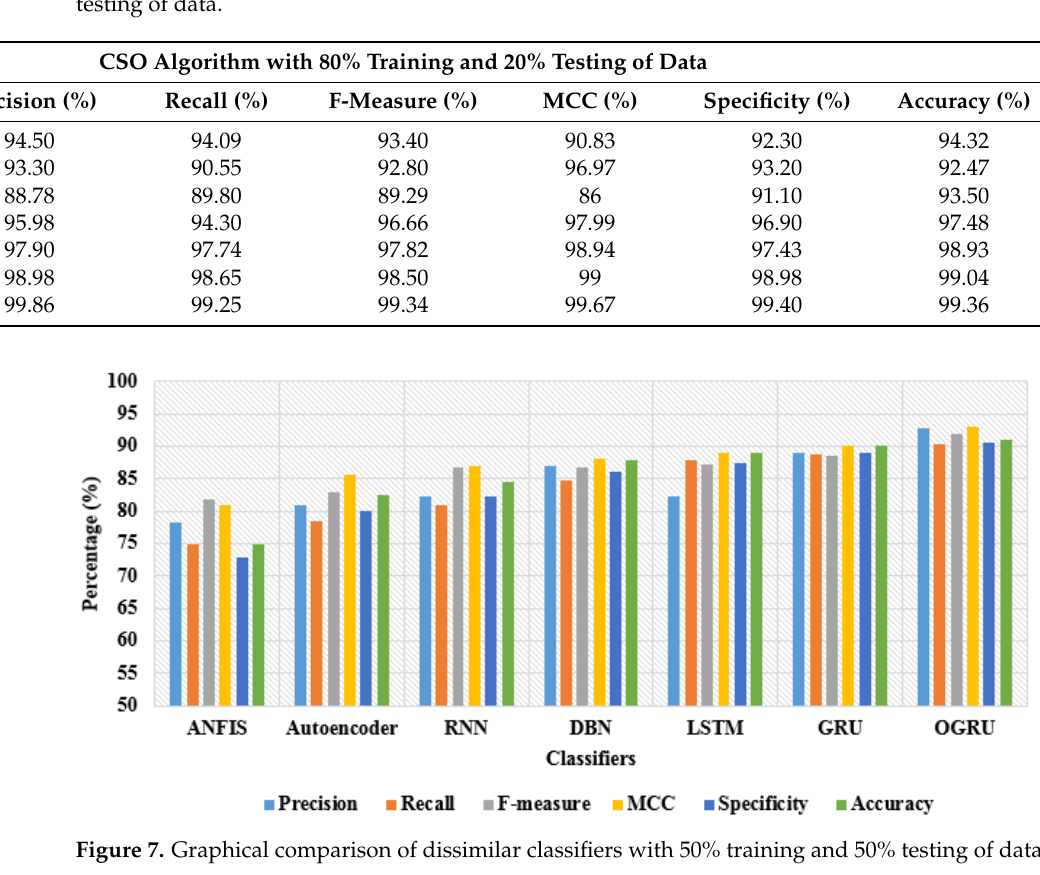
Figure 7. Graphical comparison of dissimilar classifiers with 50% training and 50% testing of data. Furthermore, the RSNA 2019 brain CT hemorrhage database is categorized into train set and test set with the ratio of 80% and 20%. In the RSNA 2019 brain CT hemorrhage database, the highest performance is achieved by the OGRU model with the CSO algorithm. The developed OGRU-CSO model achieved a precision of 99.86%, recall of 99.25%, f- measure of 99.34%, MCC of 99.67%, specificity of 99.40%, and classification accuracy of 99.36%, which are superior related to other classification techniques: LSTM, DBN, autoencoder, RNN, ANFIS, and conventional GRU model. By viewing Table 2, the proposed OGRU-CSO model is highly capable of extracting and optimizing the most discriminative features, which helps in achieving better classification with limited feature vectors. A graphical comparison of dissimilar classifiers with 80% training and 20% testing of data is stated in Figure Table 2. Simulation results of the proposed model by varying the classifiers with 80:20% training and testing of data.